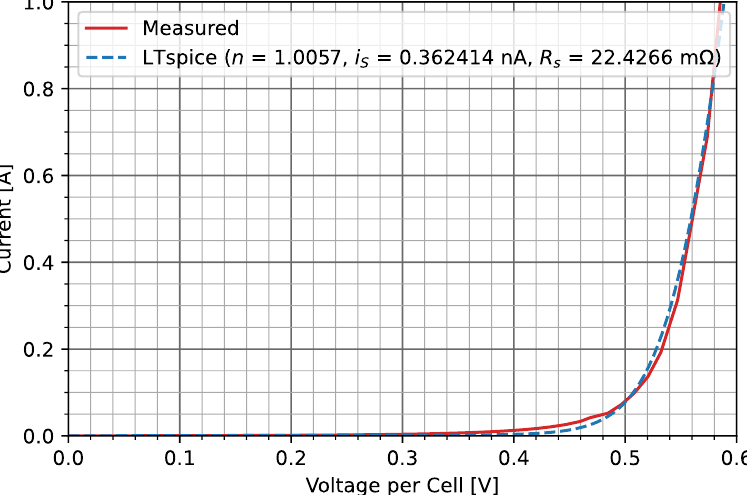
Figure 32. Large PV module measured and simulated current–voltage relationship for positive DC